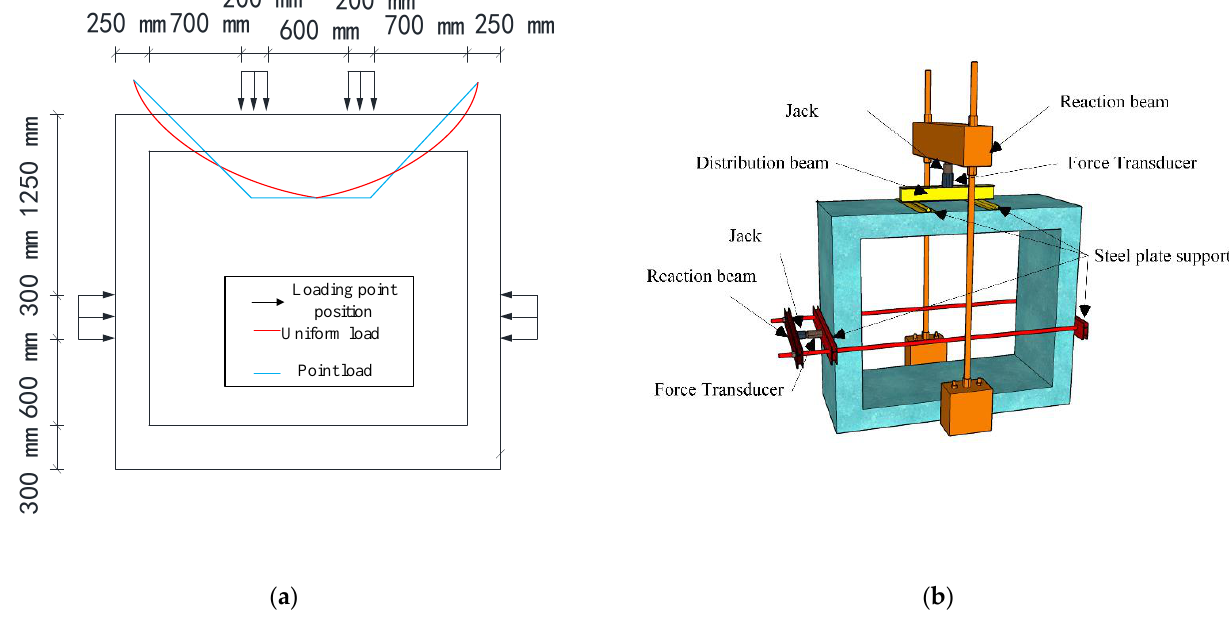
Figure 2. Support and loading position. ( a ) Front view of support and loading position. ( b ) Schematic diagram of support and loading device.